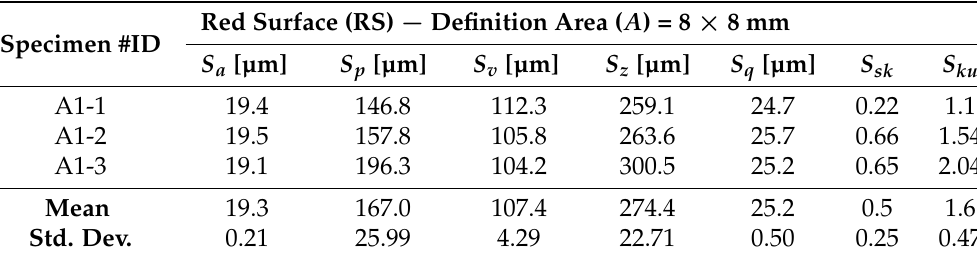
Table 6. Assessment of the repeatability of the SLM production process: red surface (RS). Specimen